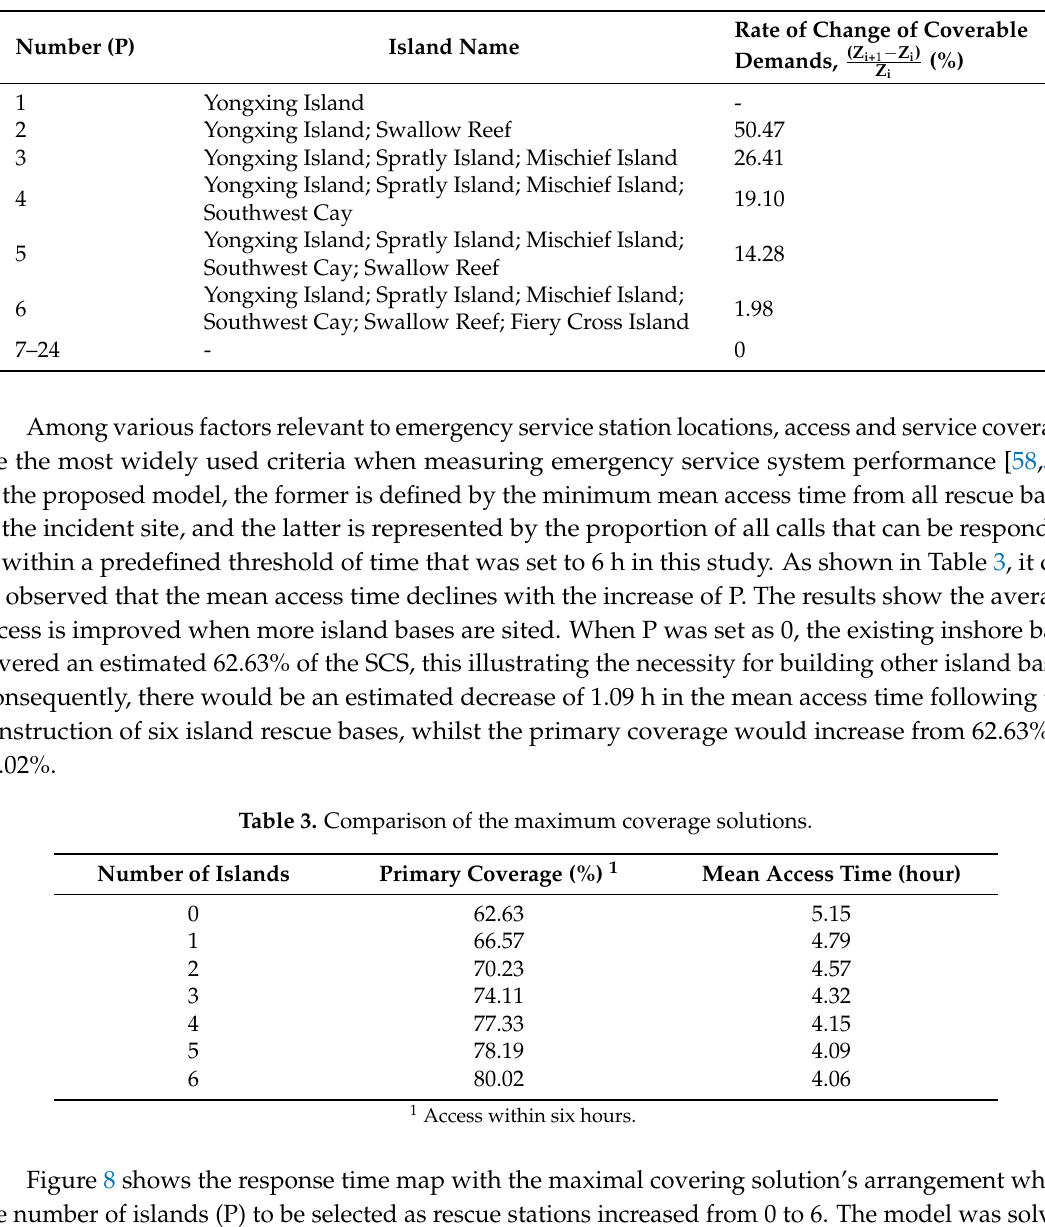
Table 2. The optimal solutions for the different number of island bases.